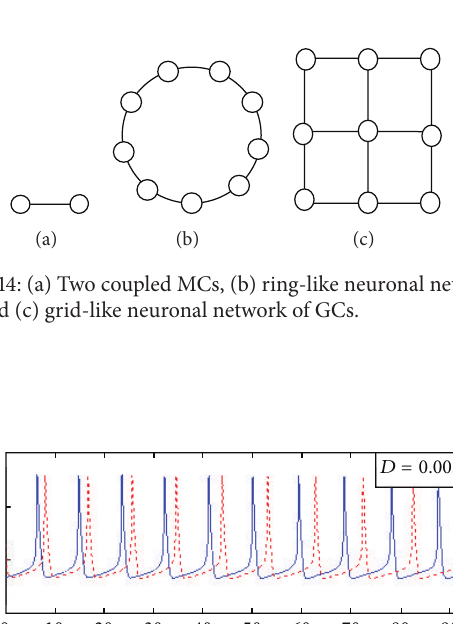
Figure 17: Membrane potential of two coupled MCs when con- nected to grid-like neuronal network of = GABA